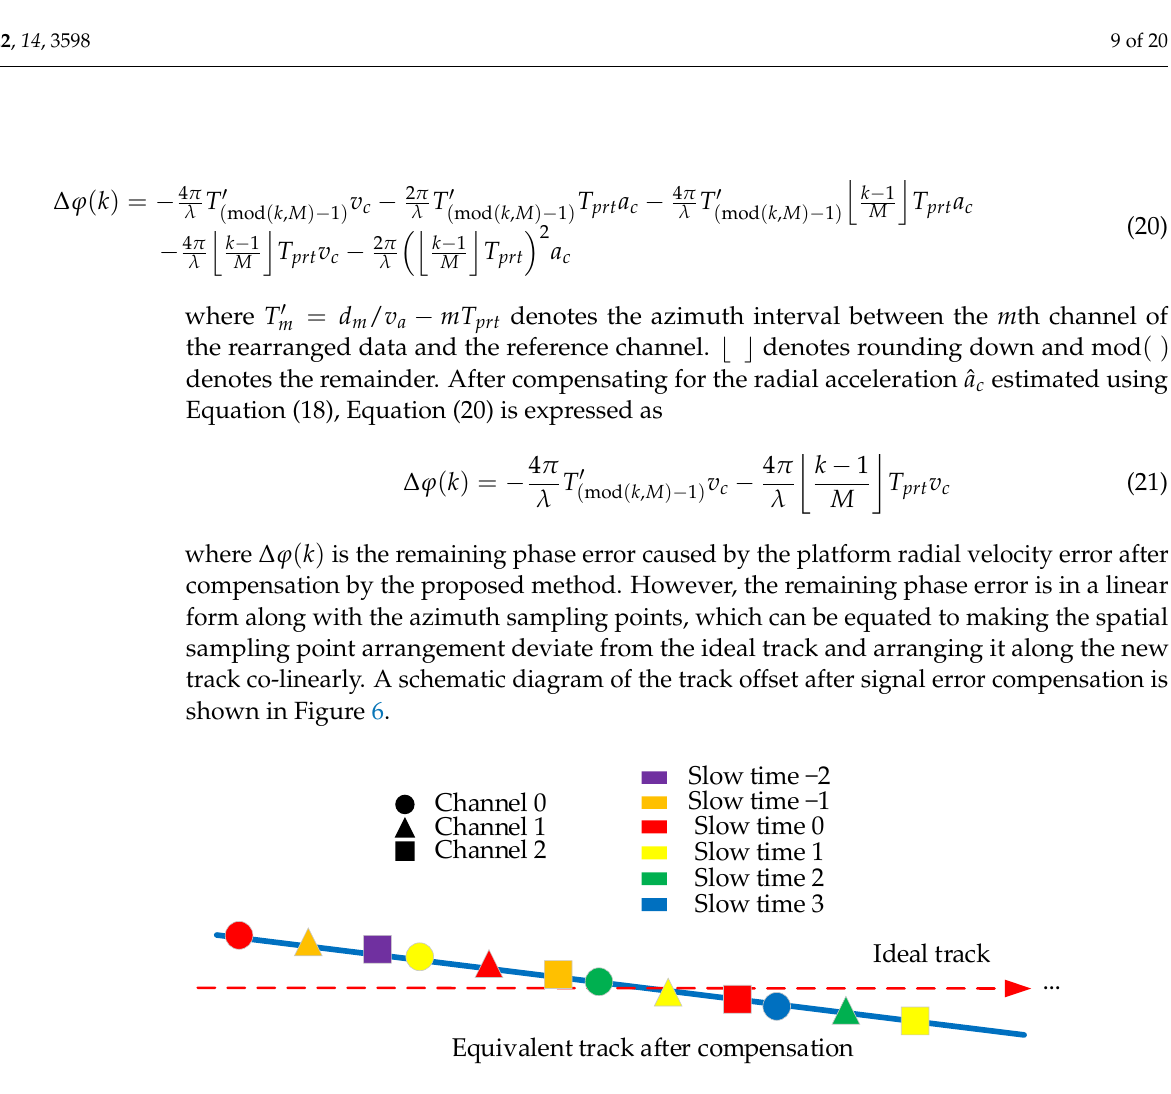
Figure 6. Equivalent trajectory offset after signal error compensation.